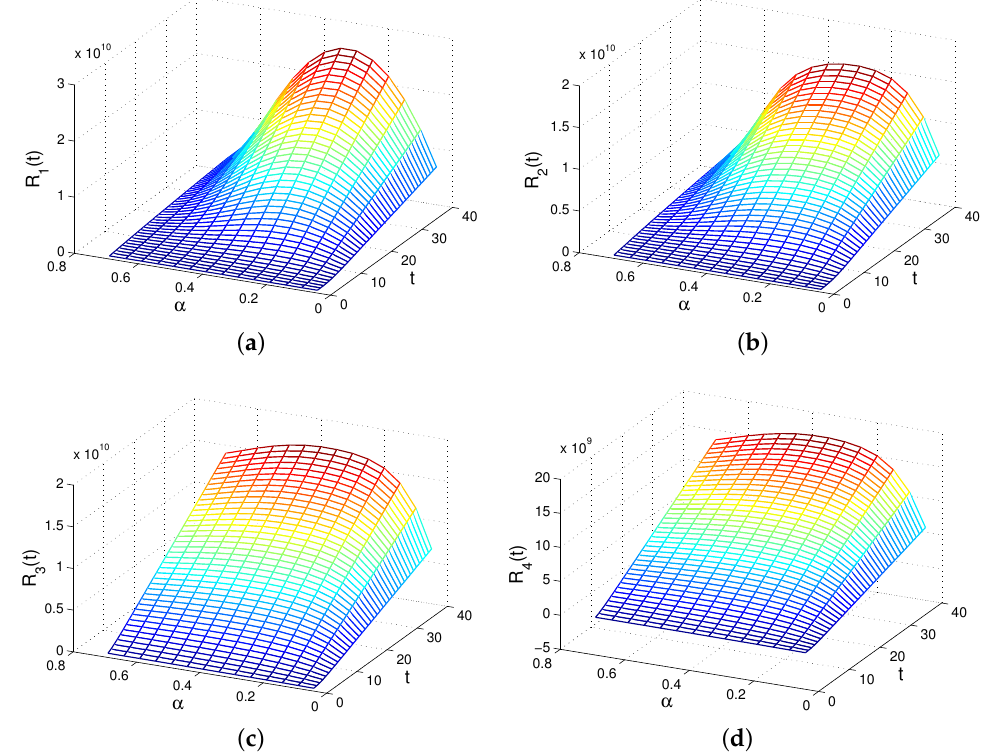
Figure 5. The impact of α on profits. The values of parameters are the first group of parameter values in Table 1 except α . ( a ) The effect of α on (6). ( b ) The effect of α on (10). ( c ) The effect of α on (14). ( d ) The effect of α on (18).